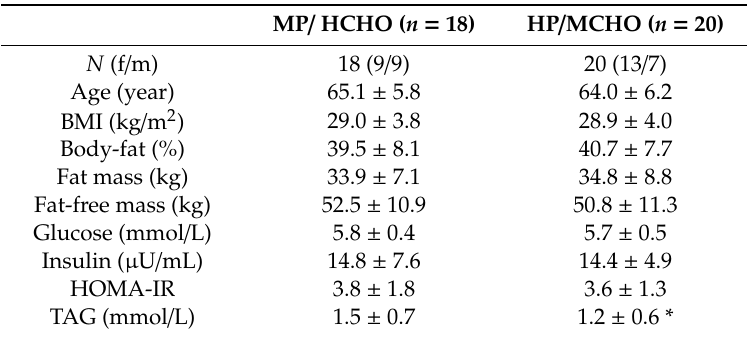
Table 1. Subject characteristics of the moderate / high carbohydrate (MP / HCHO), and high-protein / moderate-carbohydrate (HP / MCHO) group at baseline of the respiration chamber experiment.